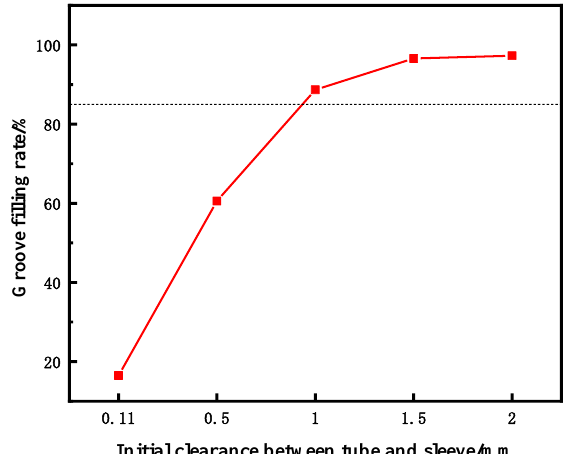
Figure 18. Variation of intercalation rate under different initial gaps at 6 kV discharge voltage.